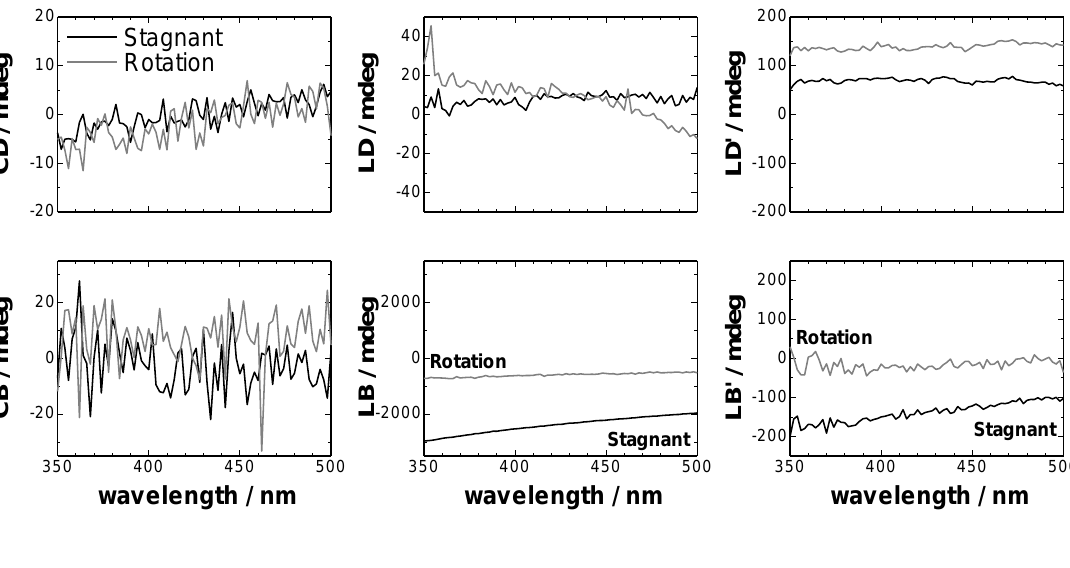
Figure 2. Circular and linear dichroisms and circular and linear birefringences of an empty CLM cell obtained from the inversion of the Mueller-Jones